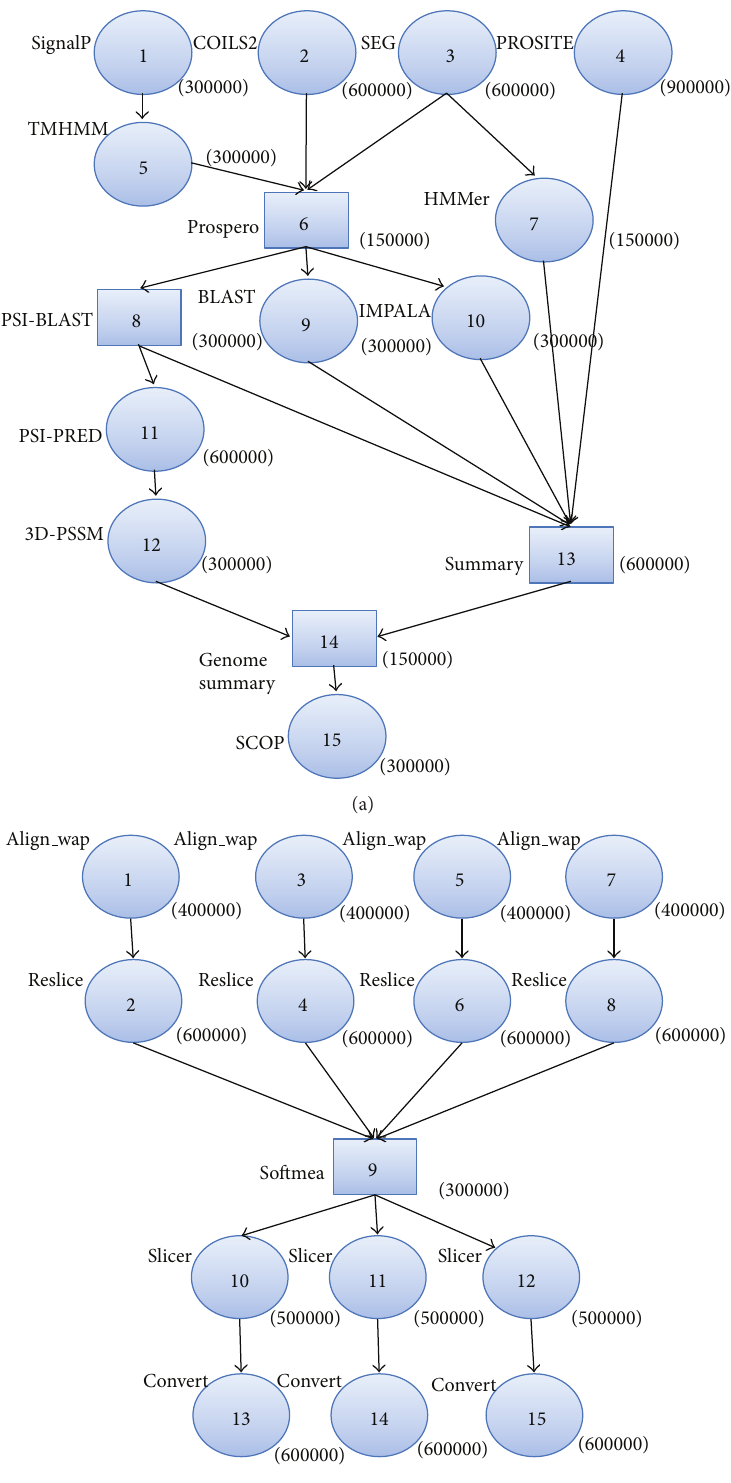
Figure 2: Parallel and Hybrid